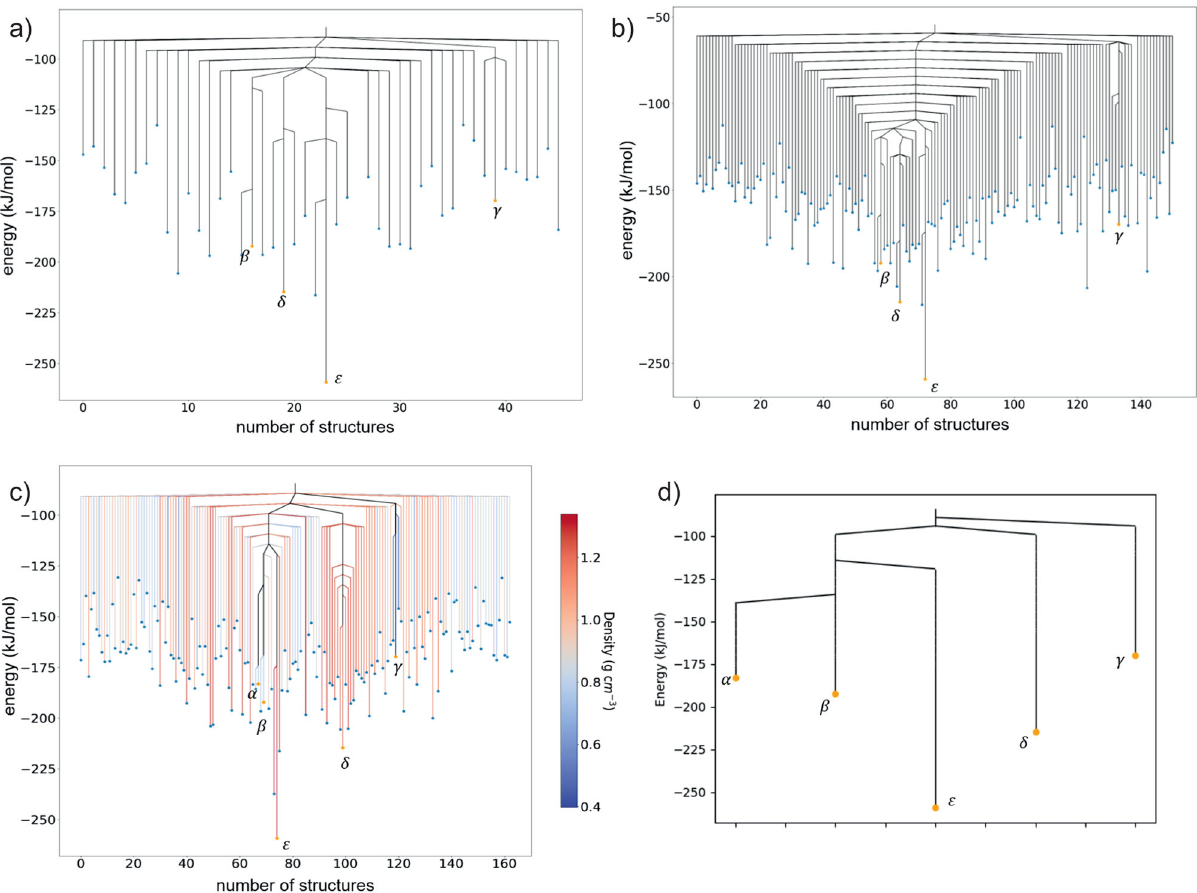
Fig. 8 Disconnectivity graphs from threshold simulations for TTBI. Threshold results are shown from sampling in space groups: a P 1 (two molecules per unit cell), b P 2 1 / c (four molecules per unit cell) and c P 1 with four independent molecules per unit cell. d A simpli fi ed graph from the simulation in P 1 with all local minima apart from the fi ve landmark structures ( α , β , δ , γ and ε ) hidden. The branches in ( c ) are coloured to show the crystal density of each structure. The horizontal axis labels the number of structures located during the threshold simulation. The order of structures is chosen to group together structures separated by low energy barriers. Disconnectivity graphs showing the entire sampled energy range are shown in Supplementary Figs. 8, 9. Table 2 Lid energies at which transitions are located between γ , α , β , δ and ε in threshold sampling in space group P 1 with four independent molecules in the unit cell (upper right entries).